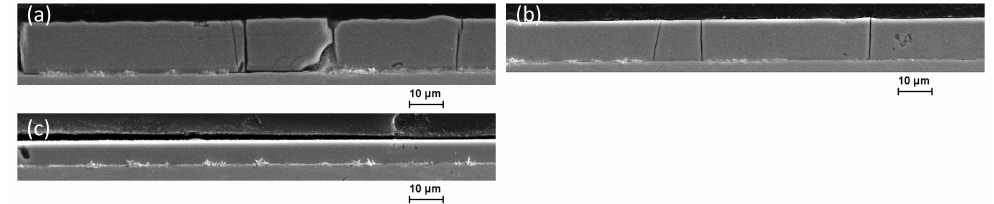
Figure 6. Scanning electron microscopy micrographs of cross-sections of electrodeposited Fe-Cr-Ni coatings under PC conditions for three depositions ( a ) after first 2 h of electrolyte use with clear microcracks, ( b ) after second 2 h with some thin microcracks, and ( c ) after third 2 h with only a small layer thickness but without any